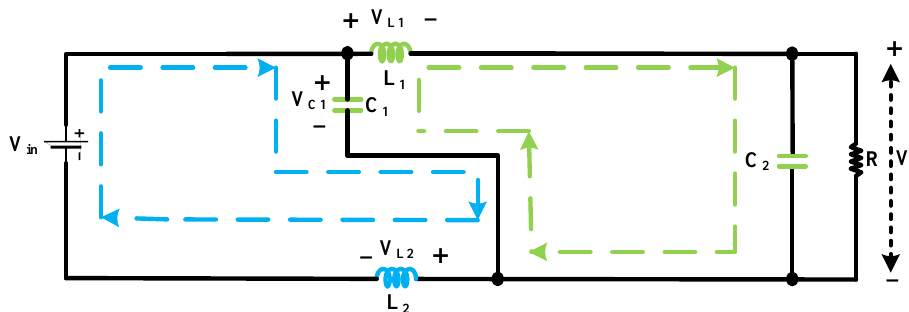
Figure 3. Conduction diagram for the second mode of operation.